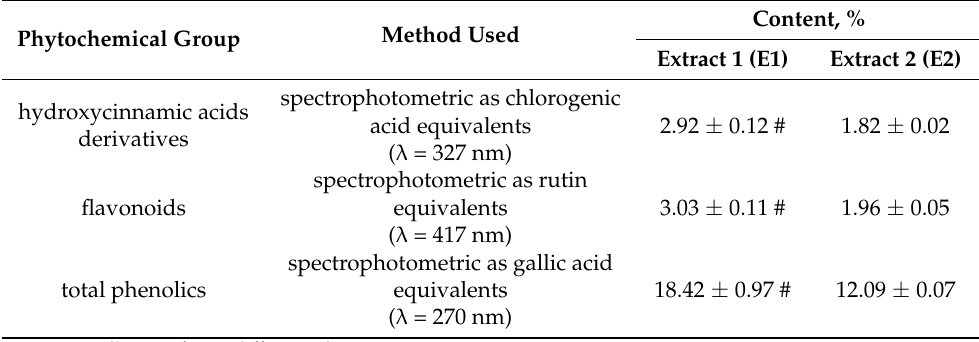
Table 3. The quantitative content of phenolic compounds in highbush blueberry leaves dry extracts (M ± m, n =